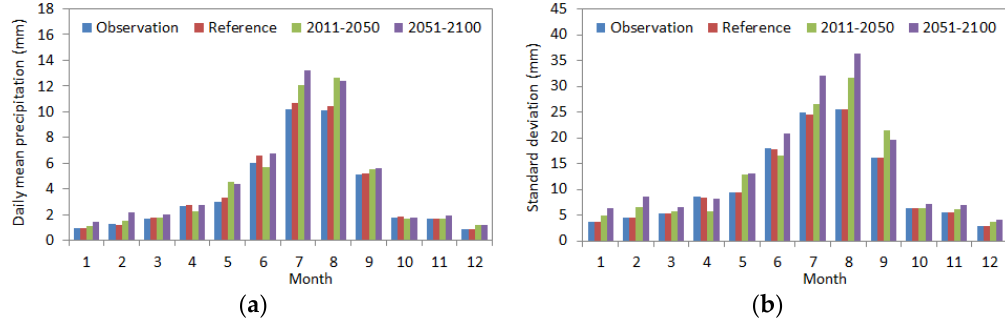
Figure 6. Daily bias-corrected precipitation of the RCP 4.5 and RCP 8.5 scenarios in each month at the Daejeon weather station. ( a ) Daily mean precipitation; ( b ) Standard deviation.